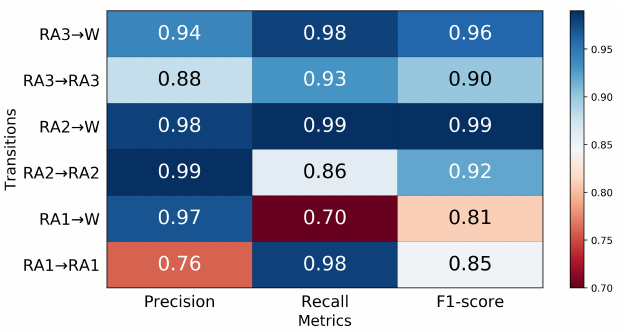
Figure 8. Confusion matrix of the average classification accuracy of the ramp ascent transitions 150ms prior to TO.